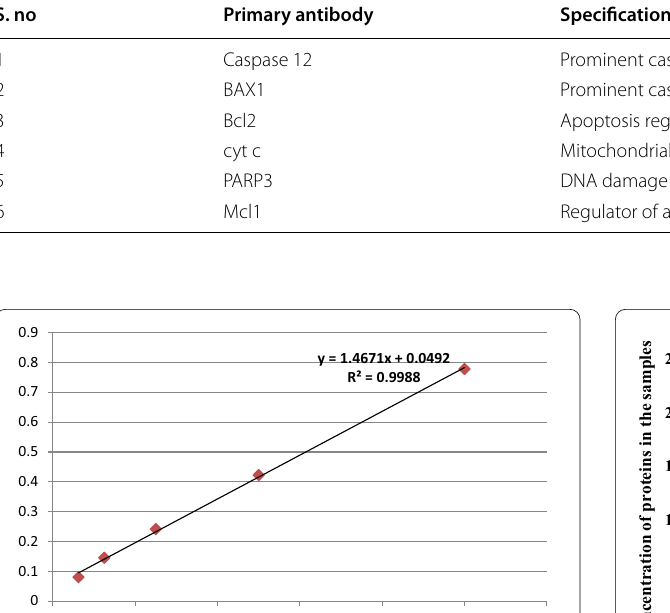
Fig. 1 Standard curve for BSA